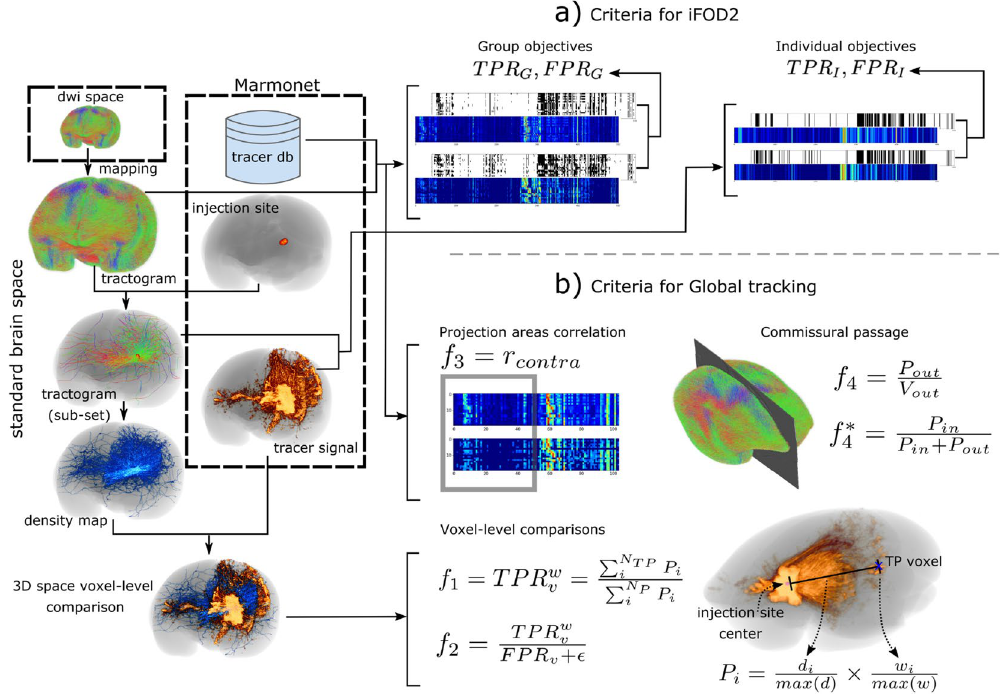
Figure 1. Criteria for evaluation. ( a, b ) show evaluation criteria for the 1st (iFOD2) and 2nd (global tracking) experiments. dMRI-based fiber tracking results are mapped to the standard brain space and intersected spatially with the injection site, allowing extraction of a subset of fibers. The full tractogram is used to compute group TPR G and FPR G (iFOD2), projection coincidence with the target hemisphere f 3 and the commissural passage f 4 (global tracking). The subset of fibers is used for individual TPR I and FPR I (iFOD2), the distance-weighted coverage f 1 and true/false positive ratio f 2 objectives (global tracking). Global tracking includes more elaborated criteria, with positive voxels weighted by two factors extracted from neural tracer data, the distance to the injection site center d i and the voxel intensity w i . Figure created using The MRtrix viewer 3.0.1 (https